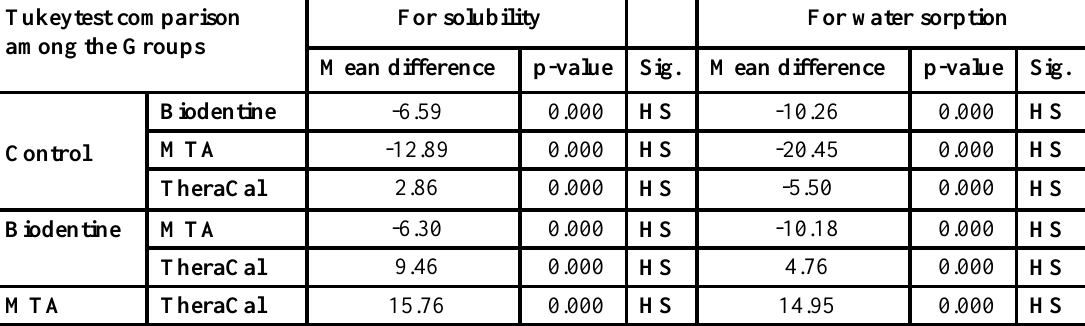
Table (5): Tukey test for comparison among the tested materials in Solubility and Water sorption. Tukeytest comparison among the